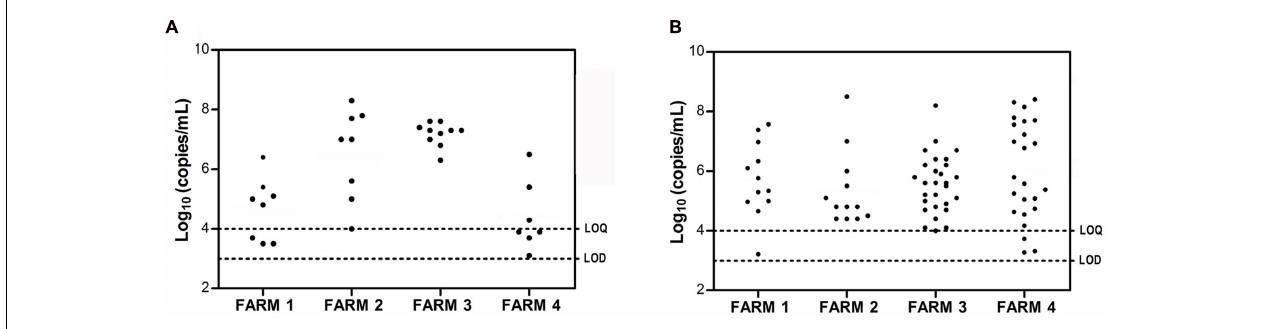
FIGURE 1 | Fecal porcine epidemic diarrhea virus (PEDV) RNA shedding of sows (A) and of 3–6-day-old piglets (B) in each farm as determined by qRT-PCR. Individual viral titers are expressed as log 10 genome copies/mL. Limit of detection (LOD) and limit of quantification (LOQ) values are